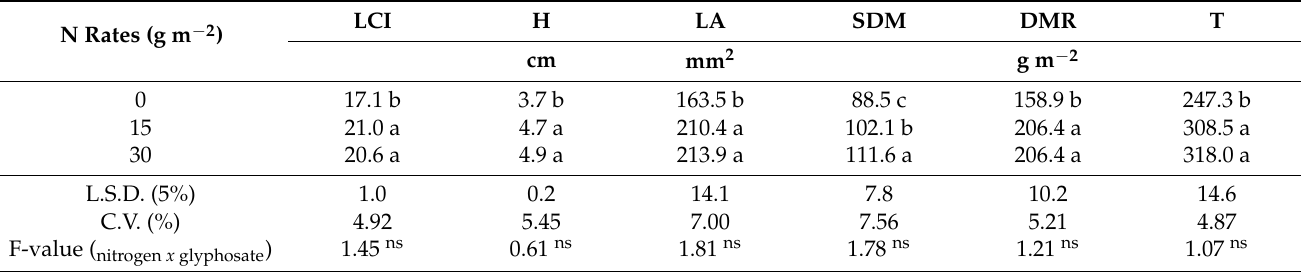
Table 1. Leaf chlorophyll index (LCI), plant height (H), leaf area (LA), shoot dry matter (SDM), dry matter of roots and rhizomes (DMR) and total dry matter (T) of emerald grass as a function of nitrogen